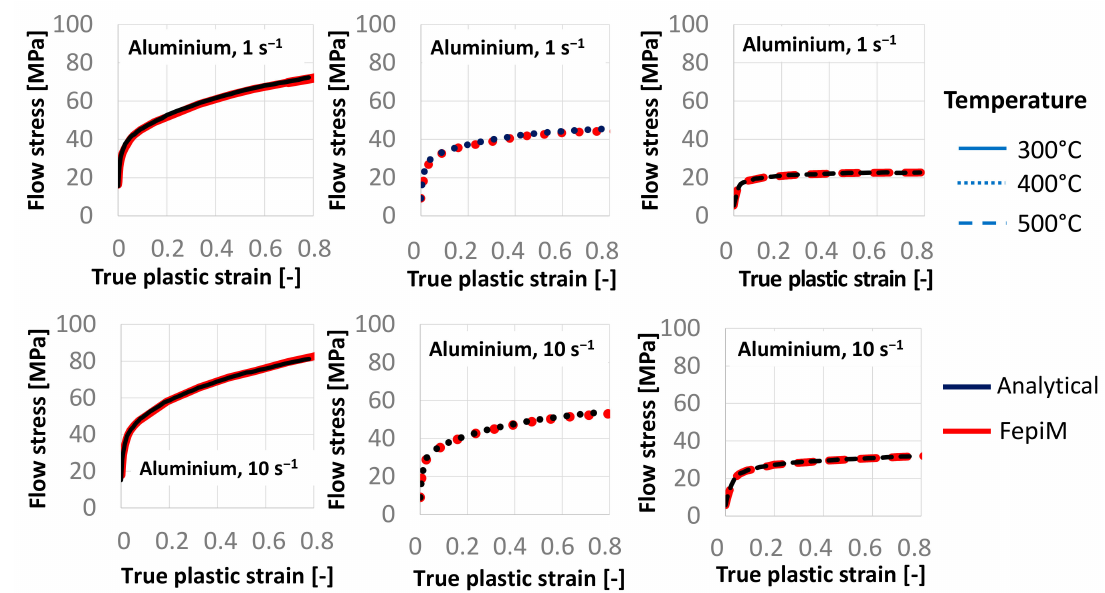
Figure 7. Flow curves for aluminum at different temperatures and strain rates.